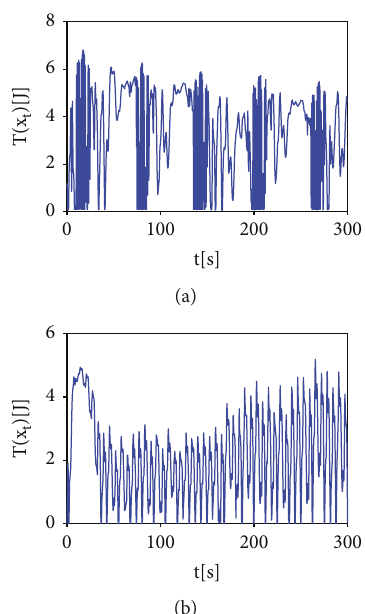
Figure 12: Total energy in the energy tank.